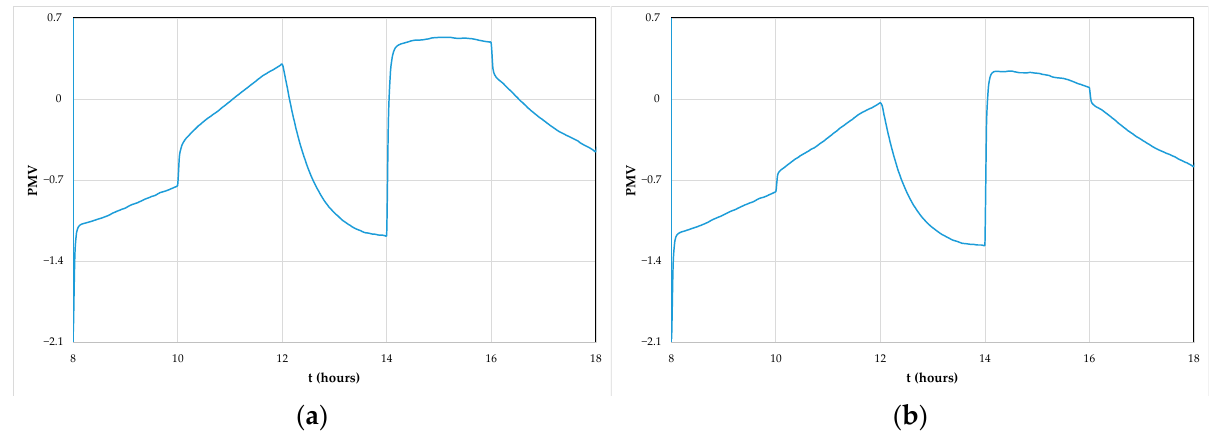
Figure 26. Evaluation of predicted mean vote (PMV) index for the Case E ( a ) and Case F ( b ).